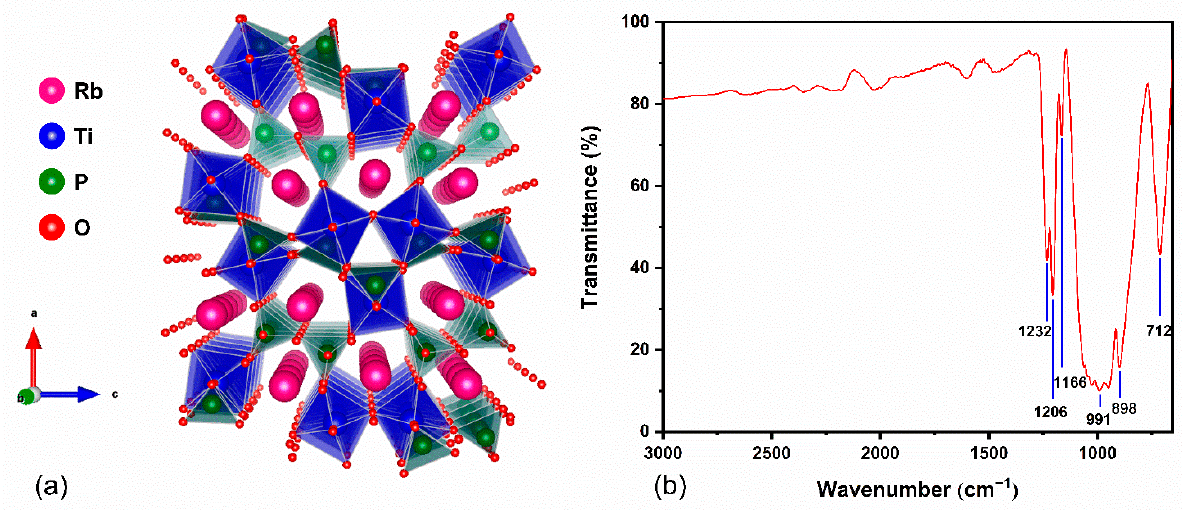
Figure 3. ( a ) The crystal structure of Rb 3 Ti 3 P 5 O 20 crystal (Rb–O bonds are deleted for clarity); ( b ) IR spectra of Rb 3 Ti 3 P 5 O 20 .